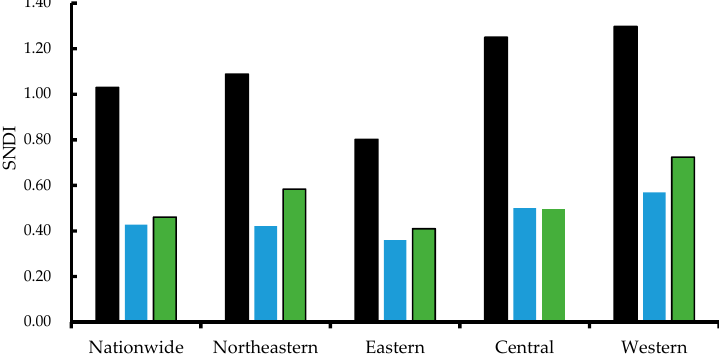
Figure 4. TNL data comparison under different correction methods, Nationwide ( ■ ), Northeastern ( ▲ ), Eastern ( ◆ ), Central ( ● ), Western (×); ( a ) uncorrected; ( b ) corrected in this article; ( c ) reference correction method. Figure 5. NDI comparison under different correction methods, Nationwide ( ■ ), Northeastern ( ▲ ), Eastern ( ◆ ), Central ( ● ), Western (×); ( a ) uncorrected; ( b ) corrected in this article; ( c ) reference correction method.